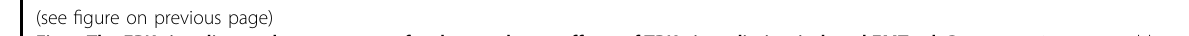
Fig. 5 The ERK signaling pathway accounts for the regulatory effects of TBK1 in radiation-induced EMT a , b Representative western blots and densitometric quanti fi cation of phosphorylated ERK at different times and with different radiation doses. c – e RLE-6TN cells were incubated with/ without the selective ERK inhibitor SCH772984 for 2 h before irradiation with 8 Gy. c , e Western blot analysis of p-ERK, E-cadherin, vimentin, and α - SMA at 1 or 48 h postirradiation. d Phase contrast microscopy images of cells at 48 h after treatment with 8 Gy irradiation. Scale bar represents 100 μ m. f The expression level of p-ERK in TBK1 knockdown RLE-6TN cells treated with or without 8 Gy irradiation was detected by western blot analysis. g RLE-6TN cells were incubated with/without SCH772984 for 2 h before irradiation with 8 Gy. Cell lysates were collected, and the protein levels of p- ERK and TBK1 at 3 h postirradiation were measured by western blot. GAPDH and ERK were used as loading controls. The data are presented as the